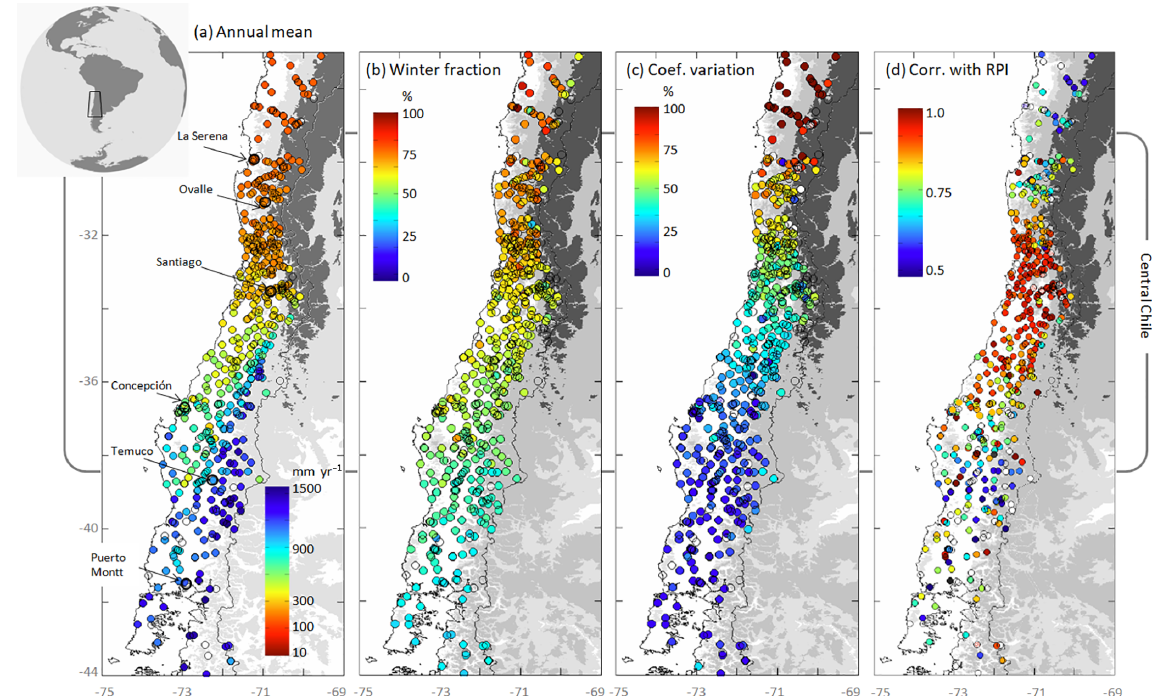
Figure 1. Long-term mean precipitation features along central Chile. (a) Annual mean accumulation, (b) winter (MJJAS) fraction of the annual total, (c) coefficient of variation (interannual standard deviation divided by the long-term annual mean, in %) and (d) correlation with the regional precipitation index (annual time series). The variables are color-coded according to their value in each precipitation station. The solid lines are the coastline and the political border. Grey and black background areas indicate terrain elevation in excess of 1500 and 3000ma.s.l., respectively. Reference period: 1980–2010.